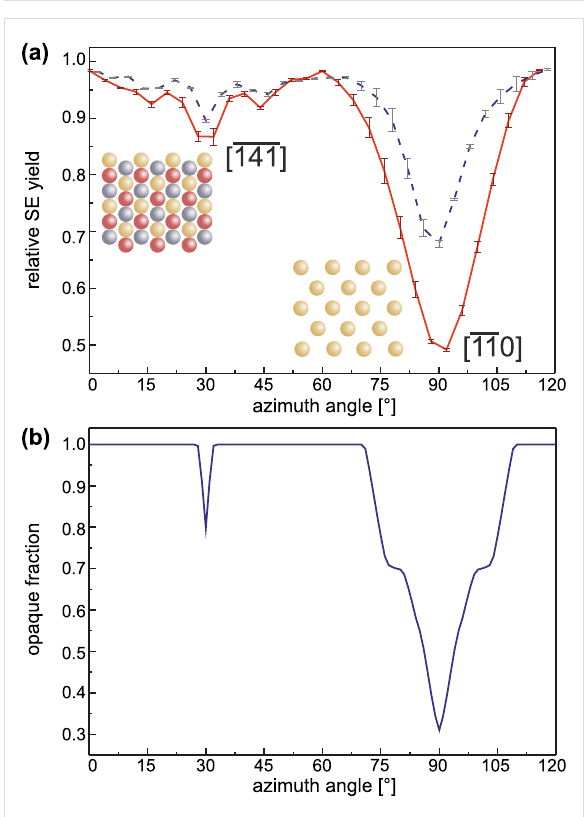
Figure 4: SE yield and opaque fraction for a polar angle of 35° with respect to the (111) plane. The azimuthal angle around the [111] direc- tion is measured with respect to the direction. (a) Experimentally obtained dependence of the SE yield on the azimuthal angle. He + PEs are 15 keV (red, solid line) and 33.6 keV (blue, dashed line). The insets present the view of the crystal along the two indicated direc- tions. The color code is as follows: gold: 1st layer, silver: 2nd layer, and red: 3rd layer. (b) Calculated opacity of a gold crystal lattice (14 atomic layers). The used effective atomic diameter is 0.68